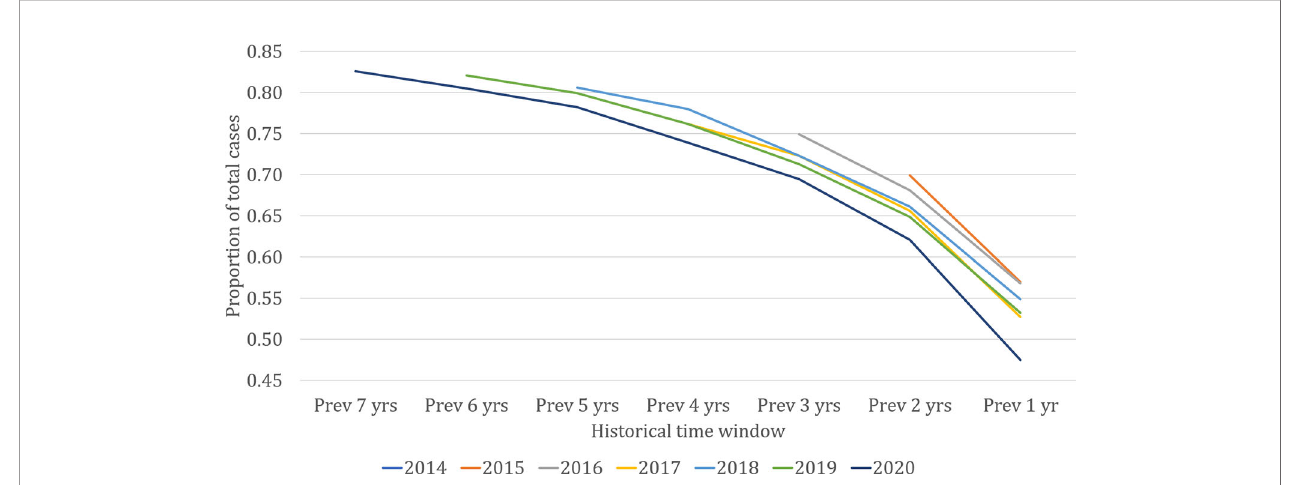
FIGURE 2 | Proportion of visceral leishmaniasis cases each year coming from previously affected villages, 2013 to 2020 (up to September). The lines represent the cumulative proportion of all cases diagnosed in each of the last seven years that came from villages with cases in the historical time window on the horizontal